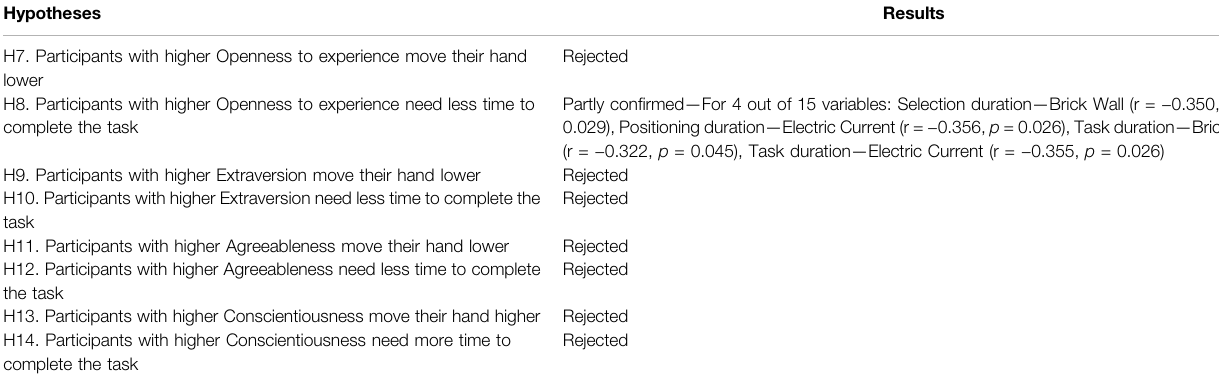
TABLE 5 | RQ2 related hypotheses results: Exploring the correlation between the Openness, Extraversion, Conscientiousness, Agreeableness traits and logged